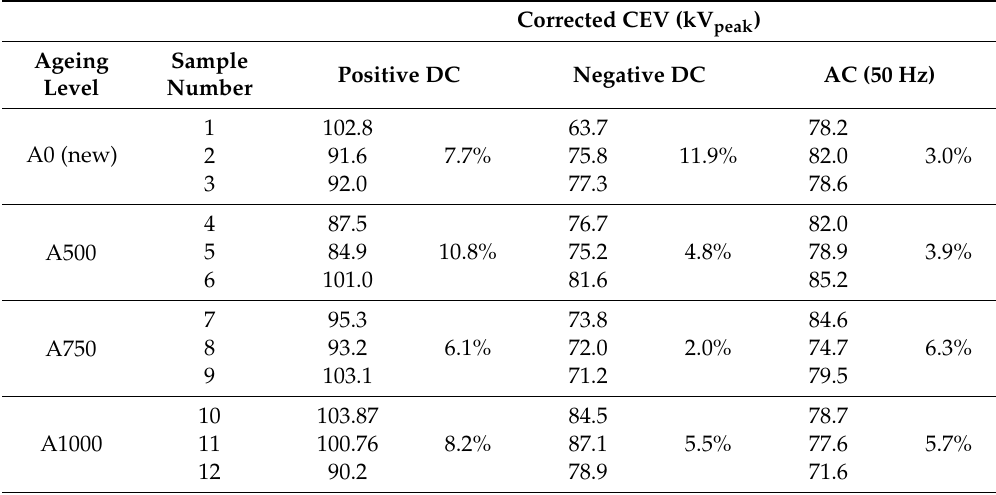
Table 4. T-type J-line connectors. Corrected corona extinction voltage (CEV) values.